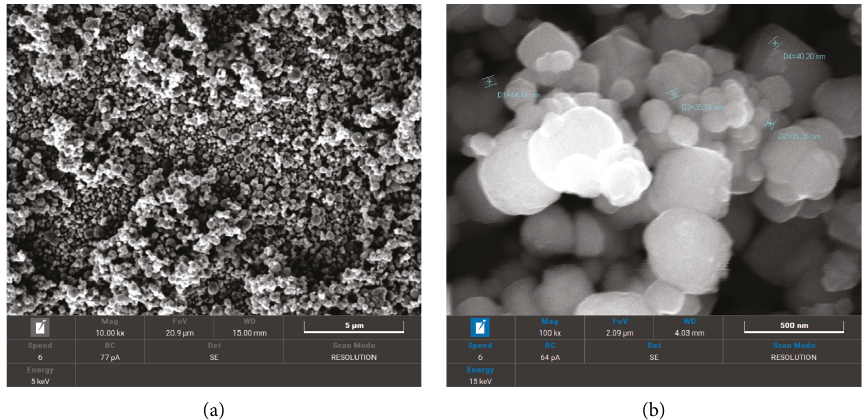
Figure 1: SEM photographs of Fe 3 O 4 nanoparticles. (a) SEM image of the Fe 3 O 4 nano powders with 10 kX magnification. (b) SEM image of the Fe 3 O 4 nano powders with 100 kX